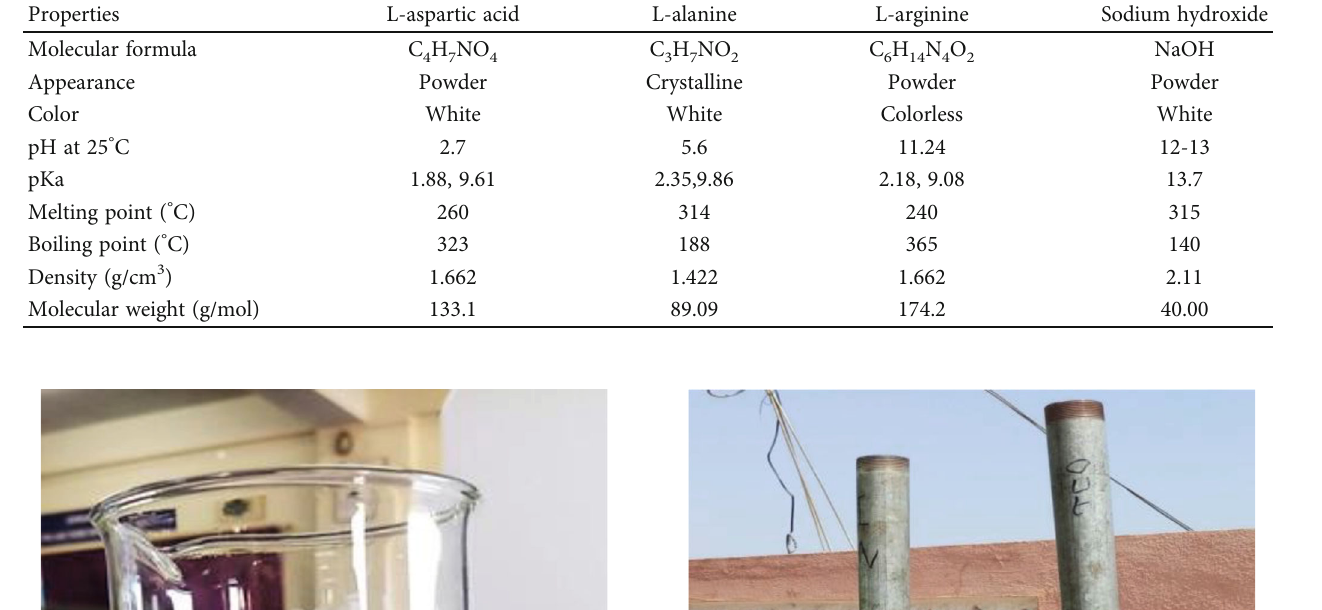
Table 1: Properties of amines.